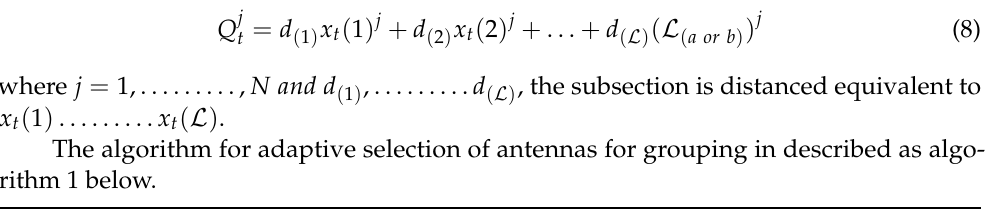
Algorithm 1: Adaptive selection of antennas for